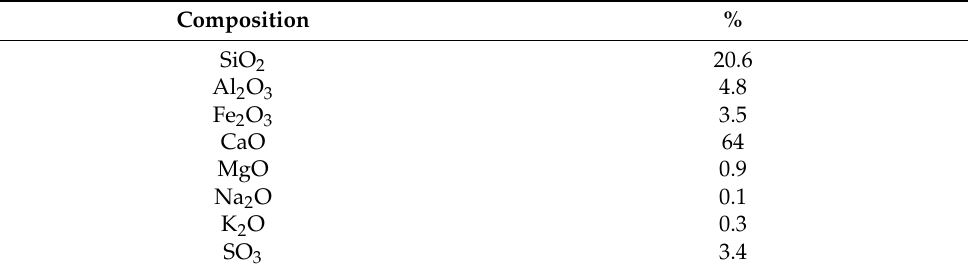
Table 2. Chemical composition of cement.